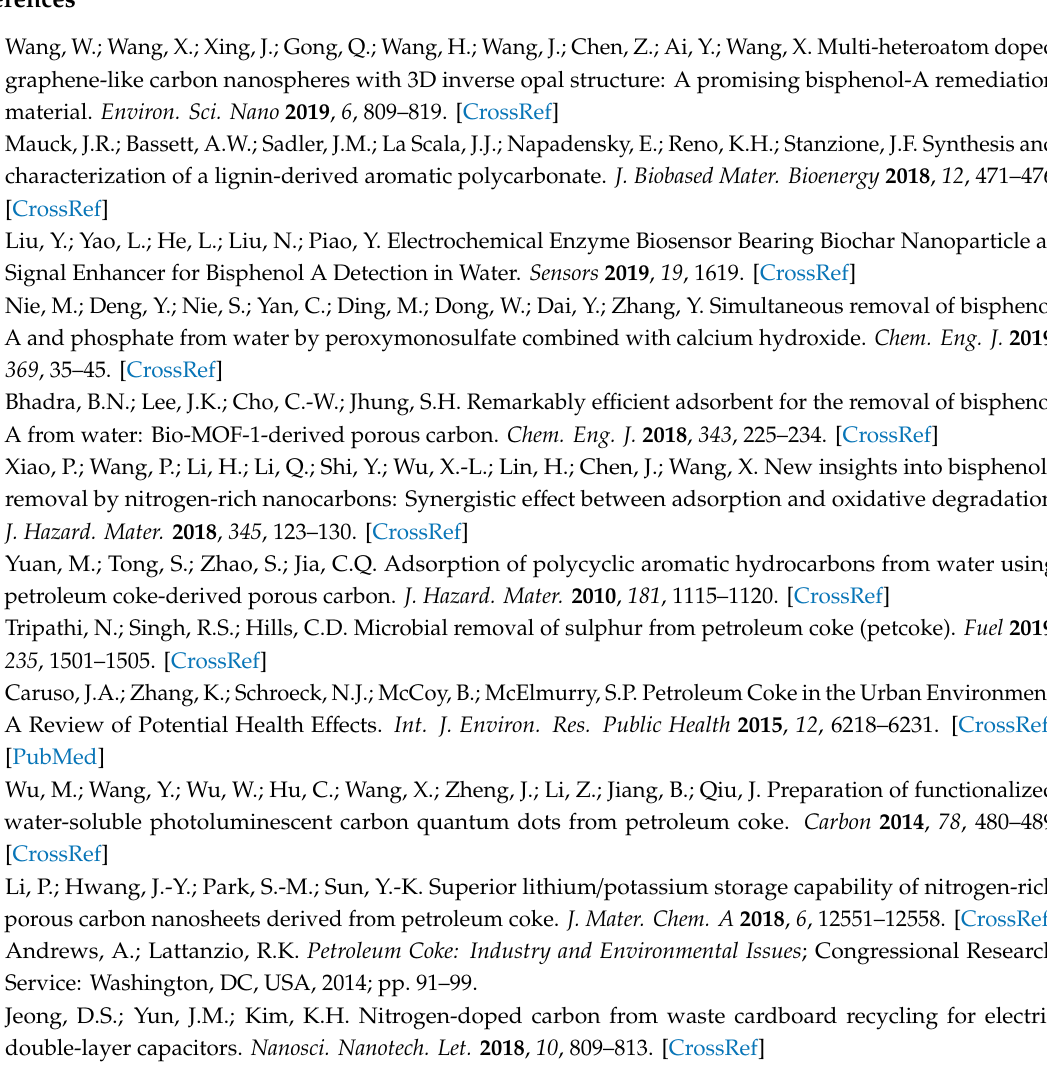
Supplementary Materials: The following are available online. Figure S1: Adsorption isotherms of BPA on N-GLPs 750 6 (experimental conditions: adsorbent dose = 7.0 g / L, initial concentration = 10–200 mg / L, contact coke; Figure S3: EDX analysis of (a) green petroleum coke and (b) petroleum coke; Figure S4: XPS survey (1) and high-resolution C 1 s (2), O 1 s (3), S 2p (4) spectra of (a) green petroleum coke and (b) petroleum coke;